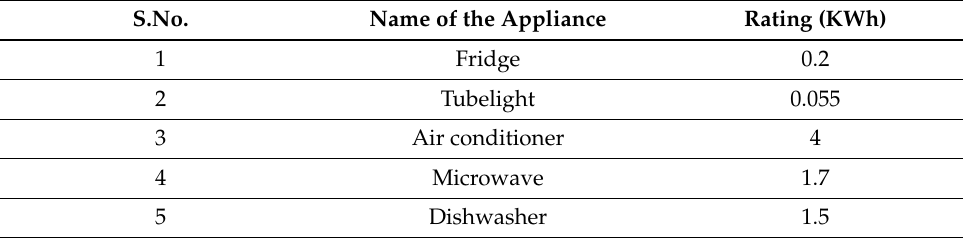
Table 4. Home appliances rating used in